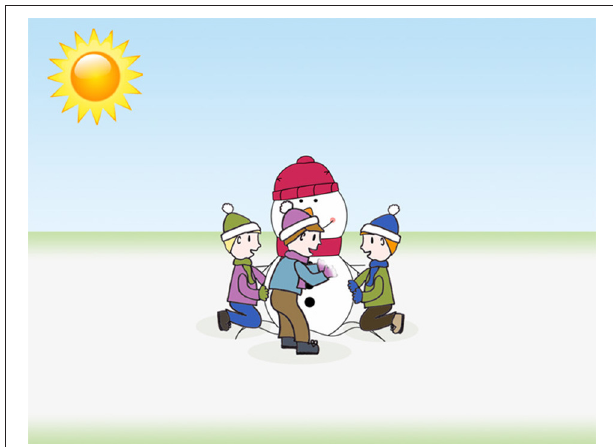
FIGURE 1 | Collective interpretation.